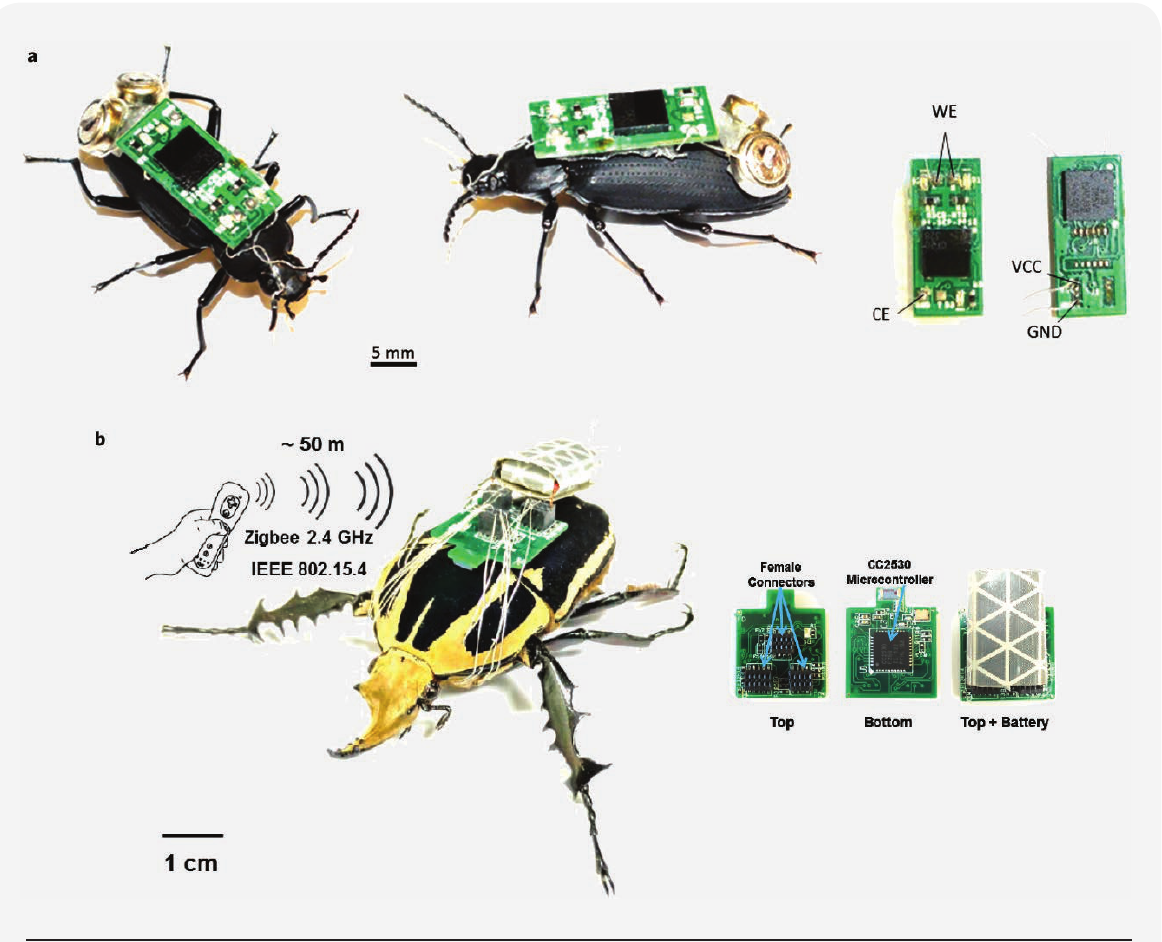
Figure 4. Two insect–computer hybrid walking robots and their backpacks. (a) A wireless stimulator backpack mounted on a living insect platform (Zophobas morio), with two working electrodes (WE), one implanted in each antenna, and one counter electrode (CE) implanted in the pronotum of the beetle. (b) Another insect–computer hybrid walking robot fully assembled on a living insect platform (Mecynorrhina torquata). The CC2530 micro- controller was programmed to elicit leg motion by stimulating eight leg muscles sequentially via 16 wire